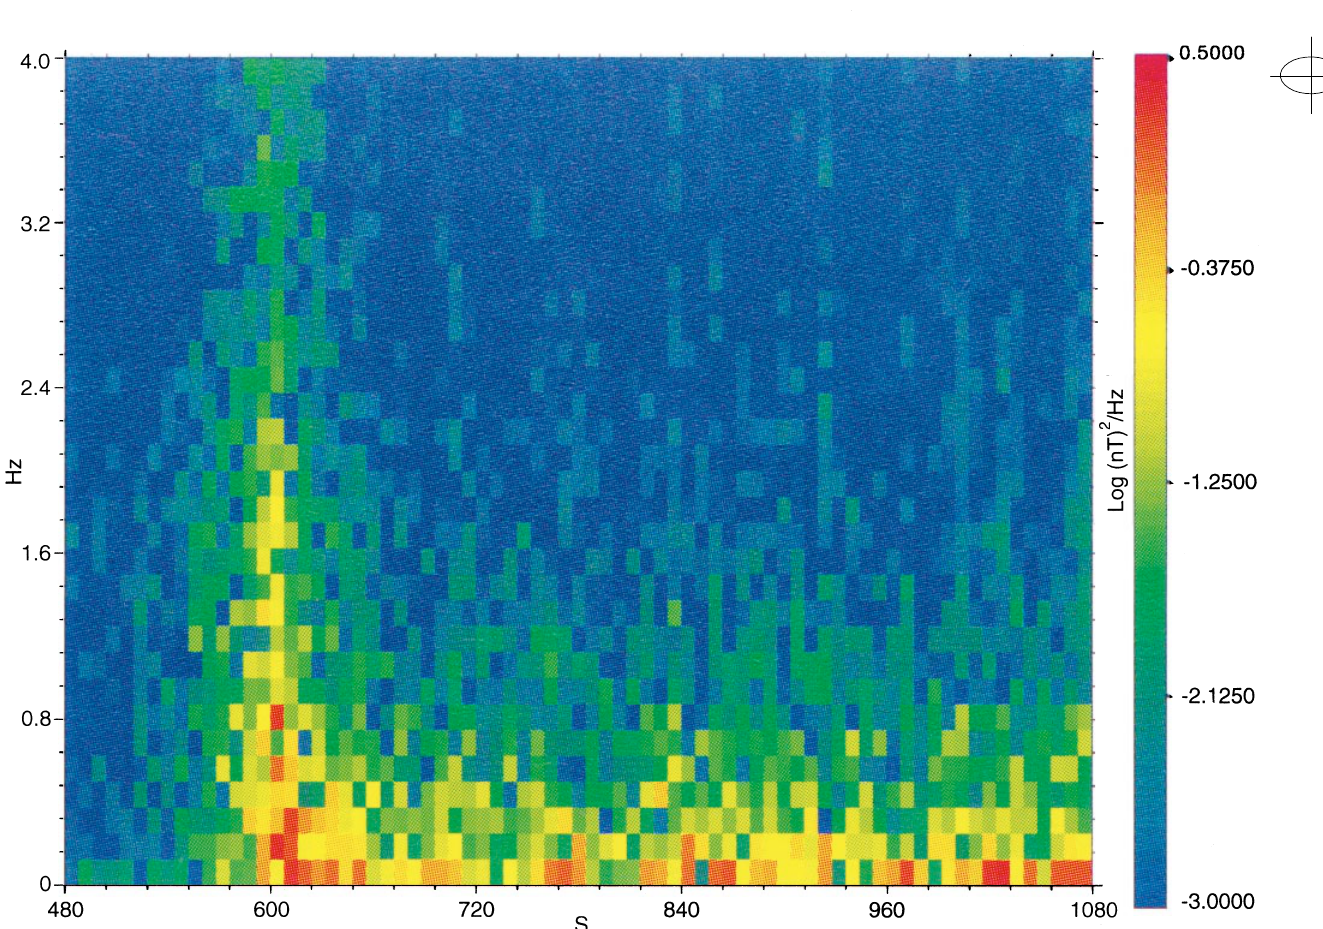
Fig. 3. Dynamic spectrum of B y component of magnetic field measured by AMPTE IRM during bow shock crossing at about 14:10:00 UT on 20.10.1984. Time scale is in seconds after 14:00:00